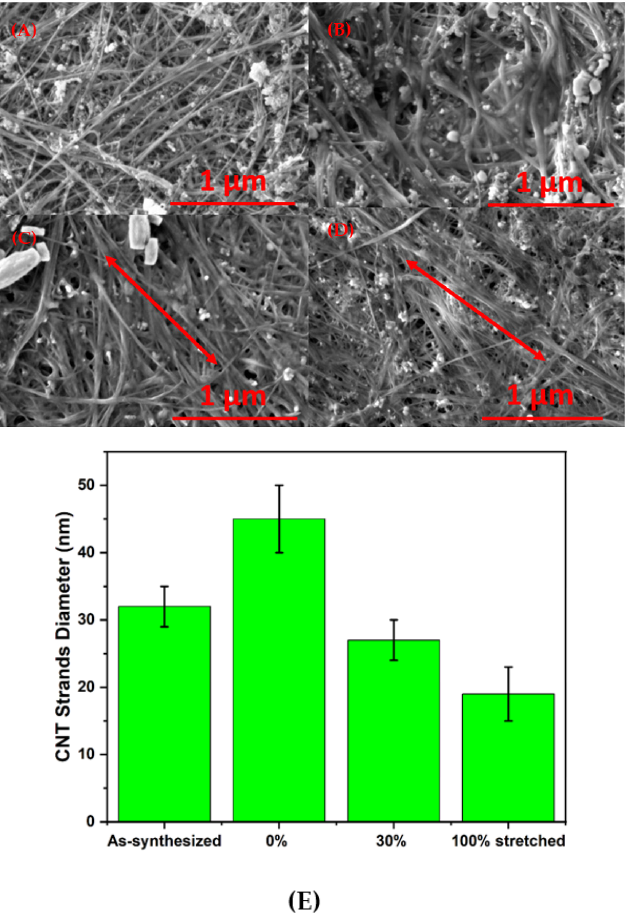
Figure 3. SEM images of as-synthesized ( A ), 0% stretched ( B ), 30% stretched ( C ), and 100% stretched ( D ) CNTs. The stretching direction is indicated by the red arrows in ( C , D ). The CNT strands diameter distribution from differently stretched CNTs is shown in ( E ).